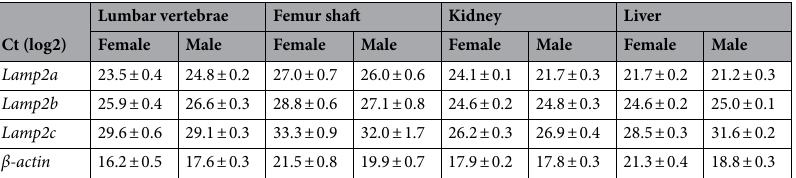
Table 1. Differential expression of Lamp2 isoforms in different tissues. Tissues were isolated from the 18-week-old wild type mice. mRNA levels of Lamp2 isoforms and control housekeeping gene beta-actin (β-actin) were measured by qRT-PCR and indicated as Ct values (log2). n = 6–10 mice/genotype.